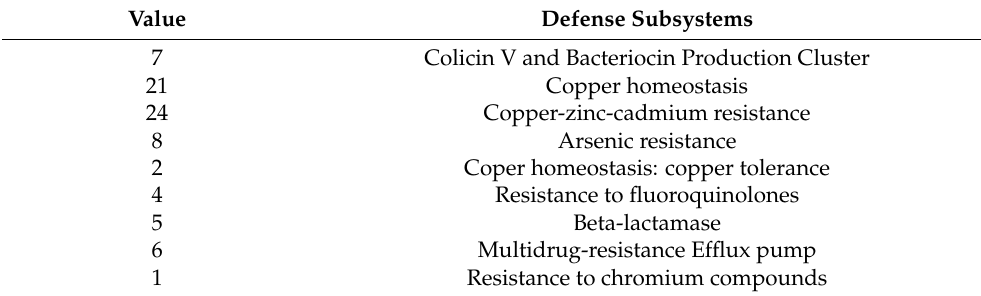
Table 2. Protein coding genes associated with the defense subsystem of Brevundimonas sp. B10. Value